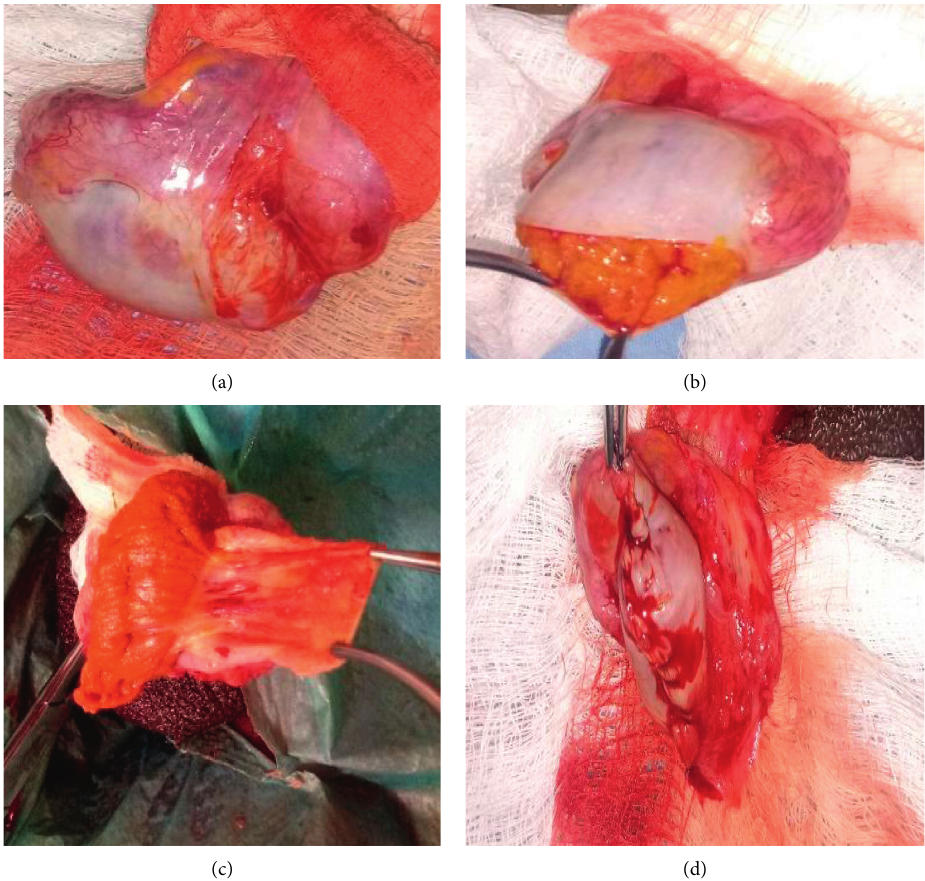
Figure 2: Subcapsular orchidectomy. (a) Vascular clamp applied. (b) Incised tunica albuginea. (c) Testicular parenchyma scraped off tunica albuginea. (d) Reapposed tunica albuginea to form a capsular